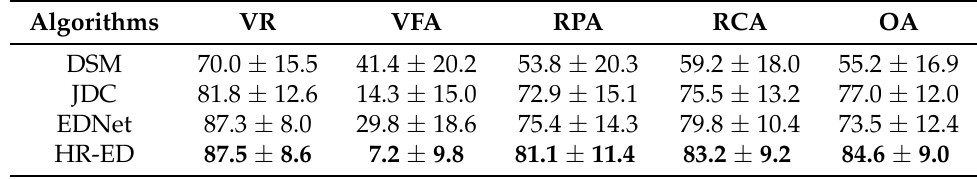
Table 6. Comparison of vocal melody extraction systems on MIR1k